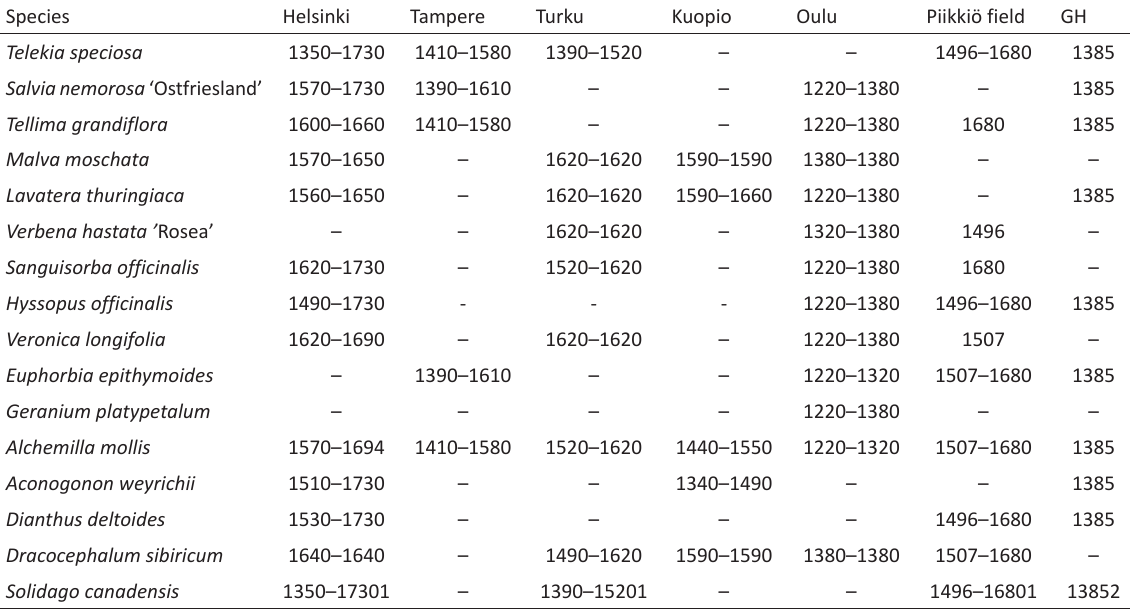
Table 8. Maximum effective temperature sum (ETS) of the three years preceding occurrence of seedlings in spring or autumn for the 15 highest ranked species and Solidago canadensis . In the Greenhouse (GH) column, ETS is for the species grown in Piikkiö field and tested in